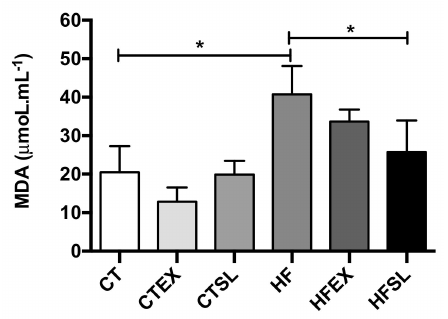
Figure 5. Hepatic MDA concentrations ( µ moL · mL − 1 ) at the end of the experiment ( n = 5 animals per group). CT: control group; CTEX: control group supplemented with beet stalks and leaves ethanolic extract; CTSL: control group supplemented with dehydrated beet stalks and leaves; HF: high-fat diet; HFEX: high-fat diet supplemented with beet stalks and leaves ethanolic extract; HFSL: high-fat diet supplemented with stalks and dried beet leaves. * Statistically significant difference ( p < 0.05).